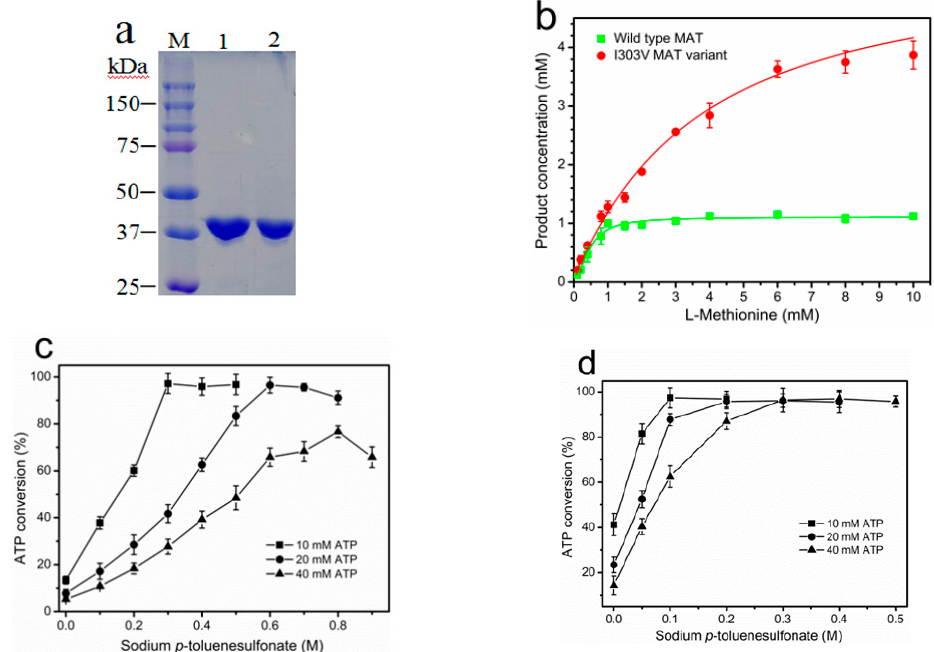
Figure 2. Conversion rates of adenosine triphosphate (ATP) catalyzed by the purified wild-type MAT and its variant I303V MAT. ( a ) SDS-PAGE (12%) analysis of the purified wild-type and I303V MAT proteins. Lane M: protein molecular weight marker. Lane 1: The purified wild-type MAT. Lane 2: The purified I303V MAT; ( b ) Production of SAM catalyzed by the wild-type and I303V MAT